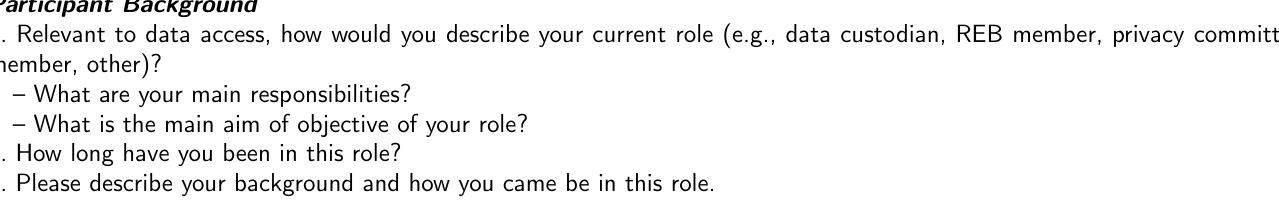
Supplementary table 2: Interview guide for researchers and research